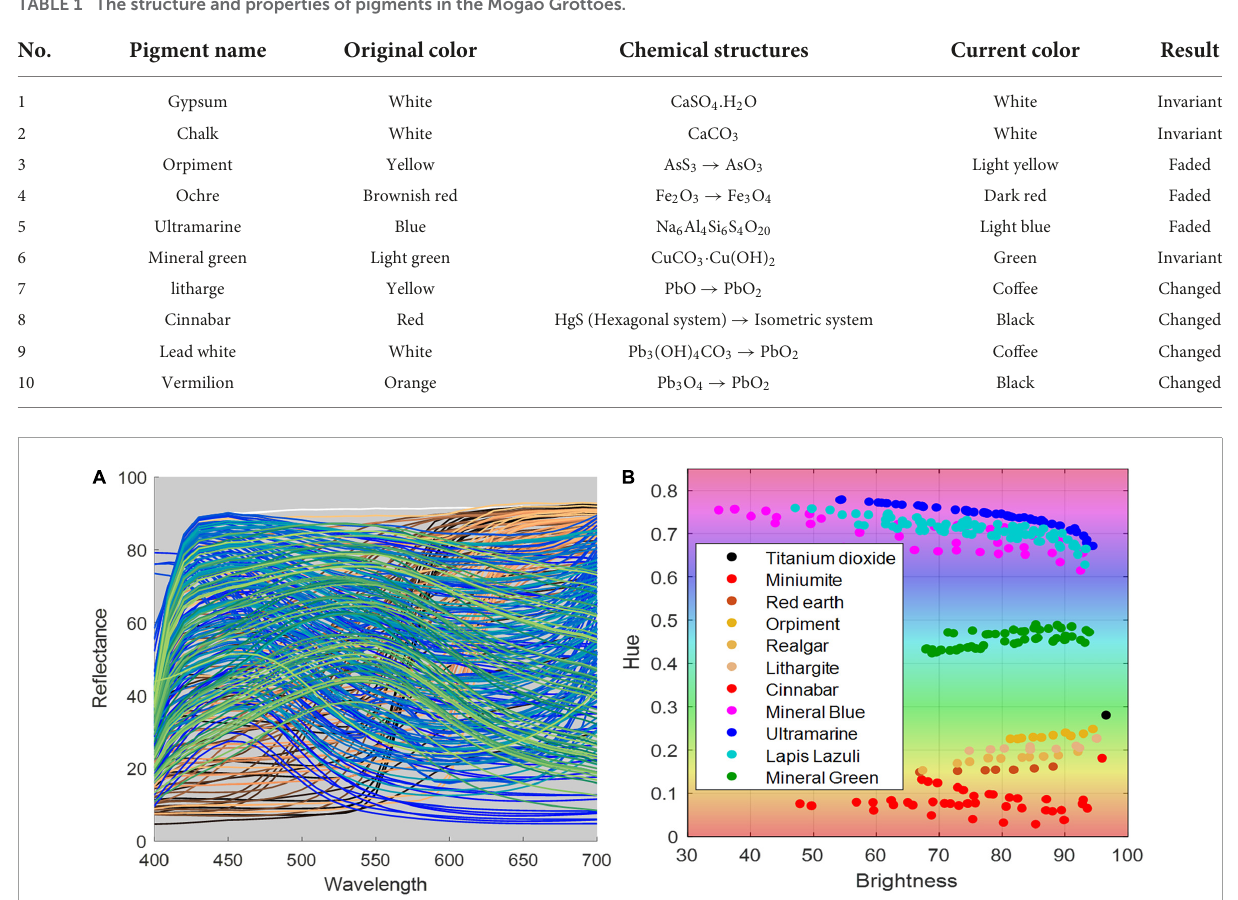
FIGURE3 The spectral and chromaticity properties of the pigments. (A) The spectral reflectance, (B) the chromaticity coordinates in the brightness-hue plane in HSV color